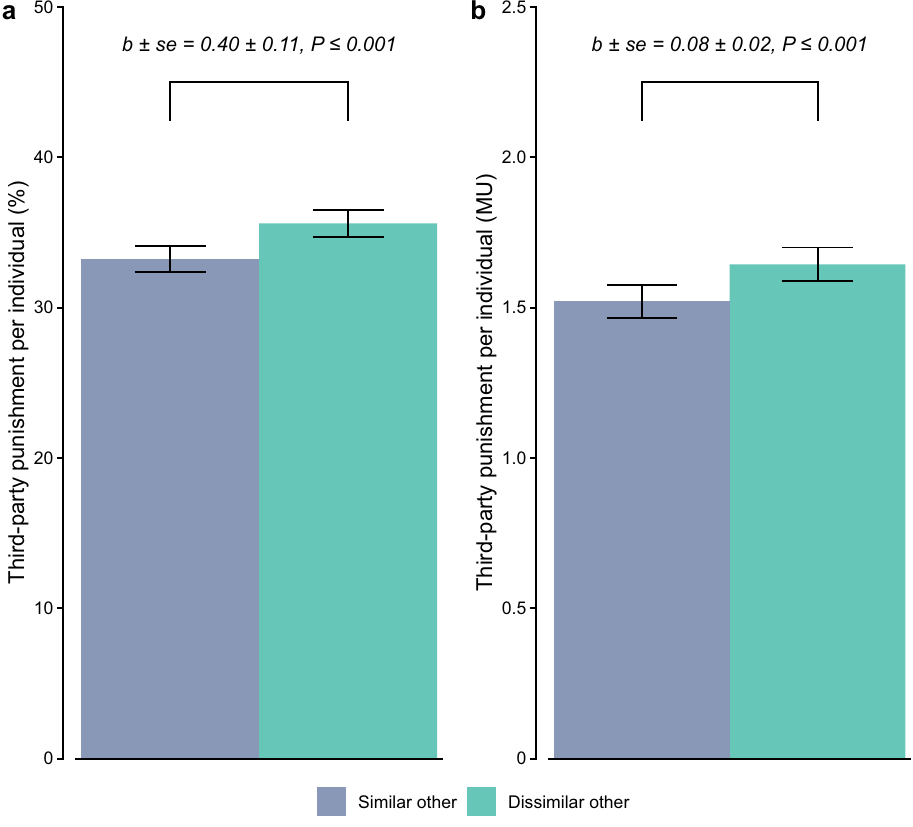
Figure 3. Discriminatory punishment in the pluriform group. ( a ) Mean (± se ) frequency of third-party punishment and ( b ) mean (± se ) expenditure on third-party punishment (per individual), as a function of target’s